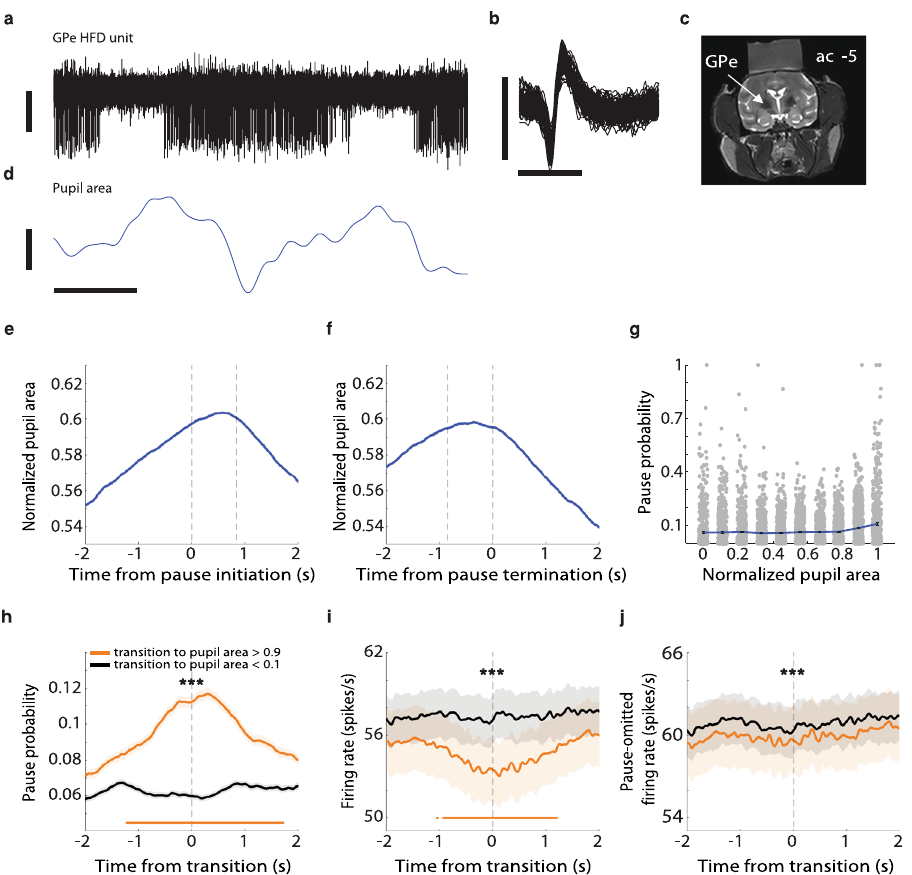
Fig. 1 The probability of HFD GPe neurons to pause spontaneously is increased when the pupils are dilated. a An example of an extracellular recording in the vicinity of a high-frequency discharge (HFD) neuron in the GPe, showing typical pauses in discharge. Vertical scale bar, 50 µ V. Data are shown after 300 – 6000 Hz digital bandpass fi ltering. b 100 randomly chosen, superimposed spike waveforms of the cell shown in a . Horizontal scale bar, 1 ms; vertical scale bar, 100 µ V. c Coronal MRI image of monkey G at the level of the anterior commissure (ac) − 5 mm, showing the location of the GPe (marked by the arrow) and the recording chamber. d An example of changes in pupil area, which was recorded simultaneously with the neuron in a . Horizontal scale bar (for both a , d ), 1 s; vertical scale bar, 20 arbitrary units (a.u.); values increase from the lower to the upper part of the bar. Data are shown after digital low- pass fi ltering with a cutoff frequency of 4 Hz. e Average pupil area around pauses ( n = 31,247 pauses). Abscissa, time ( − 2 to 2 s); ordinate, pupil area (scaled using min-max normalization). The vertical dashed lines at t = 0 and t = ~0.85 s indicate the time of pause initiation and mean pause termination, respectively. Shaded regions (can hardly be seen due to the large number of pauses) represent s.e.m. Only pauses that were recorded simultaneously with the pupil area data were included in the analysis. f Same as e , but the vertical dashed lines at t = 0 and t = ~ − 0.85 s indicate the time of pause termination and mean pause initiation, respectively. g Average population pause probability as a function of normalized pupil area. For each neuron and for each range of pupil area values (0 – 0.1, 0.1 – 0.2, … , 0.8 – 0.9, 0.9 – 1), the total time the neuron paused was divided by the overall time the pupil was in a particular area range. Each dot represents data from a single neuron ( n = 579 neurons). Error bars represent s.e.m. Only neurons that were recorded simultaneously with the pupil area data were included in the analysis. h Average population dynamics of pause probability for different normalized pupil areas. Abscissa, time ( − 2 to 2 s), zero is the time when the normalized pupil area crossed to values < 0.1 (black curve; n = 16,995 transitions) and to values >0.9 (orange curve; n = 9556 transitions); ordinate, pause probability. The orange curve is signi fi cantly higher than the black curve (*** P < 0.001, two-sided Mann – Whitney U test). The horizontal line indicates activity greater than the mean plus three standard deviations of the pause probability on the interval from − 2 to − 1.5 s. The pause probability was computed using 1-ms bins and smoothed with a Gaussian window with a s.d. of 20 ms. Shaded regions represent s.e.m. i Average population dynamics of the discharge rate for different normalized pupil areas. Abscissa, time ( − 2 to 2 s), zero is the time when the normalized pupil area crossed to values <0.1 (black curve; n = 16,995 transitions) and to values >0.9 (orange curve; n = 9556 transitions); ordinate, fi ring rate in Hz. The orange curve is signi fi cantly lower than the black curve (*** P < 0.001, two-sided Mann – Whitney U test). The horizontal lines indicate activity lower than the mean minus three standard deviations of the fi ring rate on the interval from − 2 to − 1.5 s. j Average population dynamics of the discharge rate after removal of pause-containing segments. Same conventions as in i